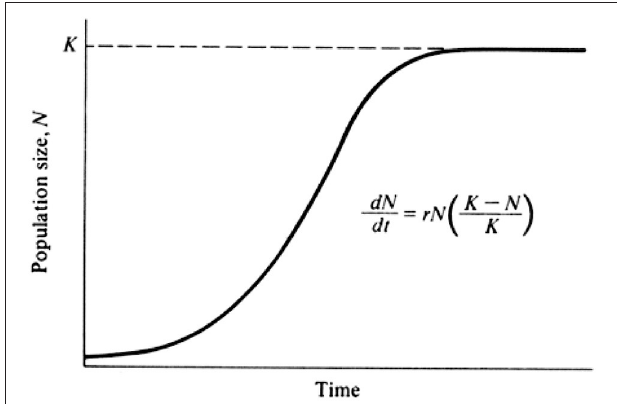
FIGURE 1 | The logistic growth curve resulting from density-dependent population dynamics. K is the asymptote or predicted carrying capacity of an idealized population and r is the intrinsic rate of increase. The equation is positioned at approximately the same height as the inflection point K/2, which is predicted to be the point of maximum sustainable yield, MSY ( Pianka, 2000). Defined simply, the carrying capacity (K) is the maximum number of individuals that can be supported in each area at a given time. In populations following density-dependent population dynamics, the upper asymptote of the logistic growth curve is assumed to approach K because the average death rate and rate of recruitment of juveniles to adulthood equilibrate, and growth stops. The presence of carrying capacity, the prediction of logistic growth, and the point of MSY are all testable predictions of a general theory that may not be accurate or even exist in specific cases. Indeed, real populations vary in the shape of their growth curves, and these characteristics can change over time ( Brook and Bradshaw, 2006; Ratikainen et al., 2008). Birth and death cannot be assumed to change symmetrically or non-linearly with density or population size. For example, with strictly territorial species, local density may not even increase much within a local subpopulation (see Box 2 for an example). Even if the other conditions are met, the inflection point can lie higher or lower than K/2, depending on the symmetry of the birth and death curves in relation to density. Caution is warranted because of the vicissitudes of wild ecosystems, environmental stochasticity, and the uncertainty of any predictions about the future that are based on past patterns (Brook and Bradshaw, 2006; Ratikainen et al., 2008; Oro, 2013; Williams, 2013 ). Data limitations especially relating to migration into and out of the open ecosystems also commonly restrict our knowledge of growth rates of natural populations. Also, the predictions of sustainable use models become increasingly uncertain when mortality and natality are affected by unregulated factors, untested policies, or human errors ( Fryxell et al., 2010). This is not to say that MSY is a fallacy, but rather that it is a prediction that needs frequent updating, continual review, and testing, rather than an a priori static